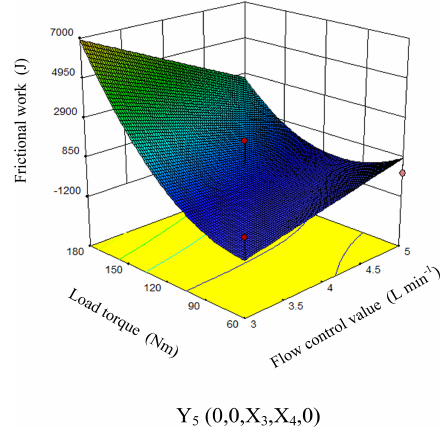
Figure 13. Influence of interaction on frictional